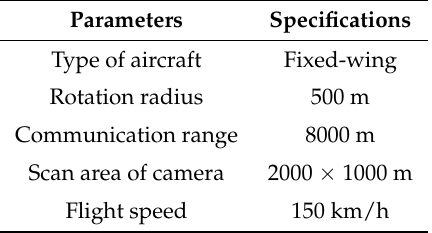
Table 1. Performance of the simple